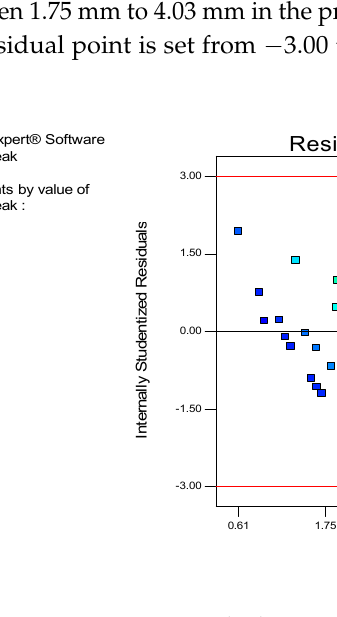
Figure 17. Residual vs. Predicted points.